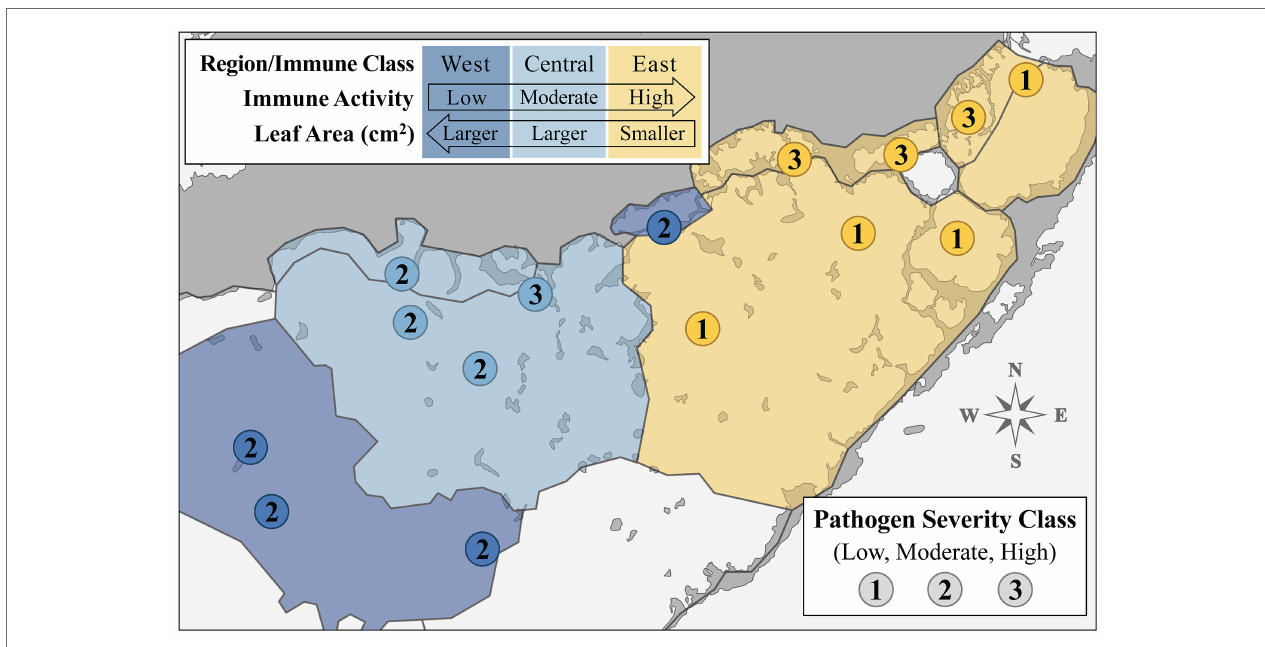
FIGURE 4 | Map displaying site-level immune activity (color) and pathogen load (number label) classes layered over the biogeochemical segmentation of Florida Bay (RECOVER, 2010; Herbert et al., 2011) to effect designation of overall “immune response zones.” Numbers labeling each site represent pathogen severity class. Biogeochemical segments shaded according to associated immune class sites. Legend arrows indicate directional trends observed in composite enzyme measures (immune activity) and morphology (leaf area in cm 2 ) across the spatial gradient of sampled Florida Bay